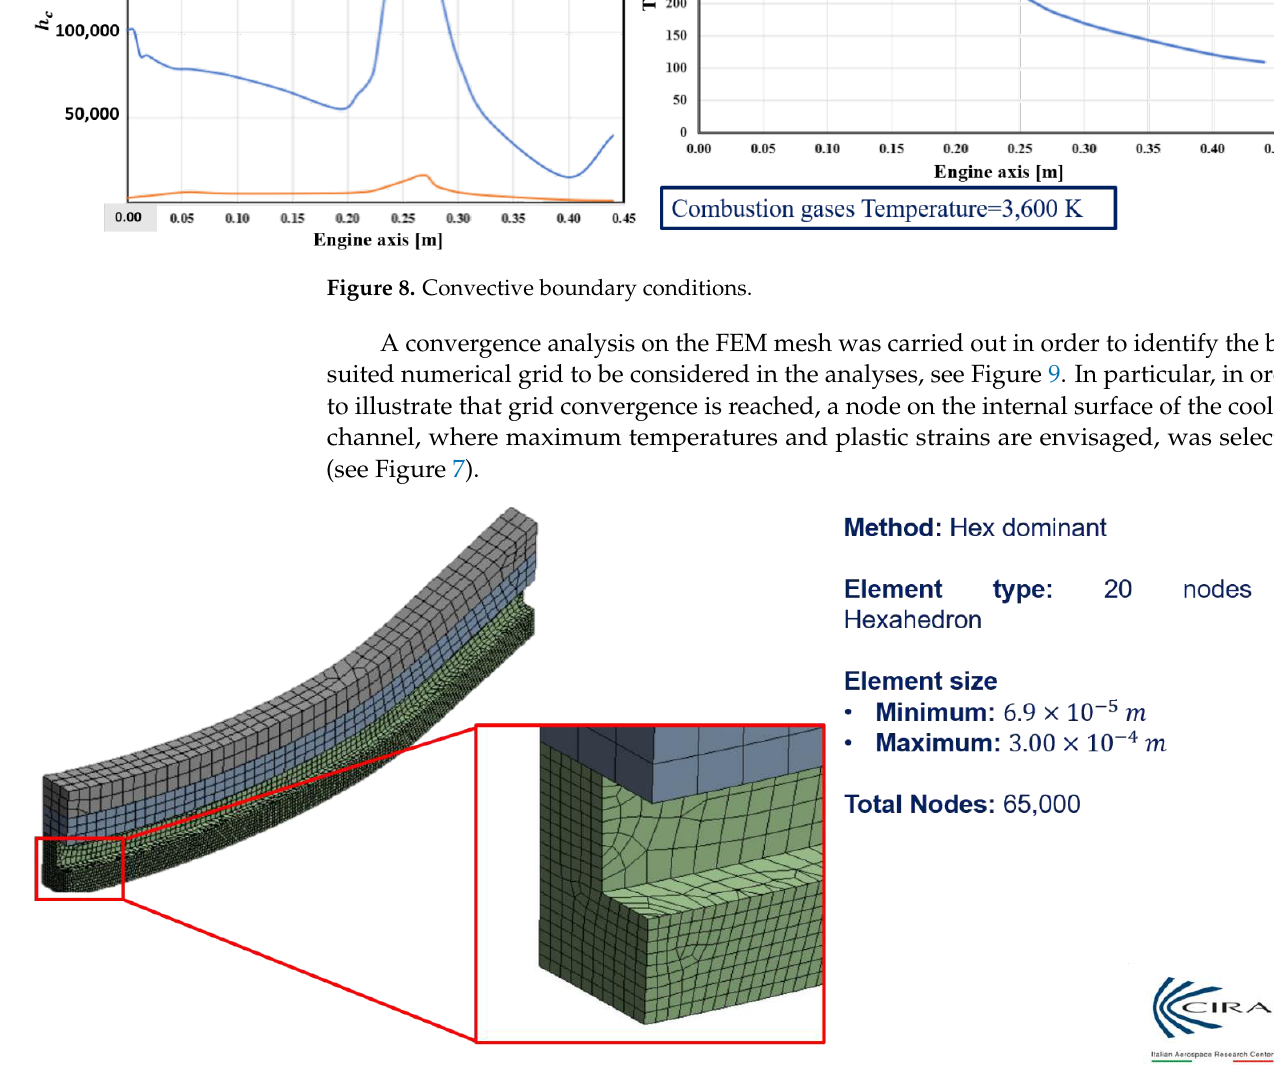
Figure 9. FEM mesh adopted in the numerical analyses as derived from the convergence analysis.